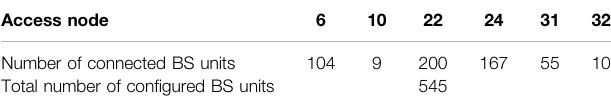
TABLE 2 | Optimal con fi guration results of battery storage (BS) in the isolated micro-grid without considering demand-side response (DR). Access node